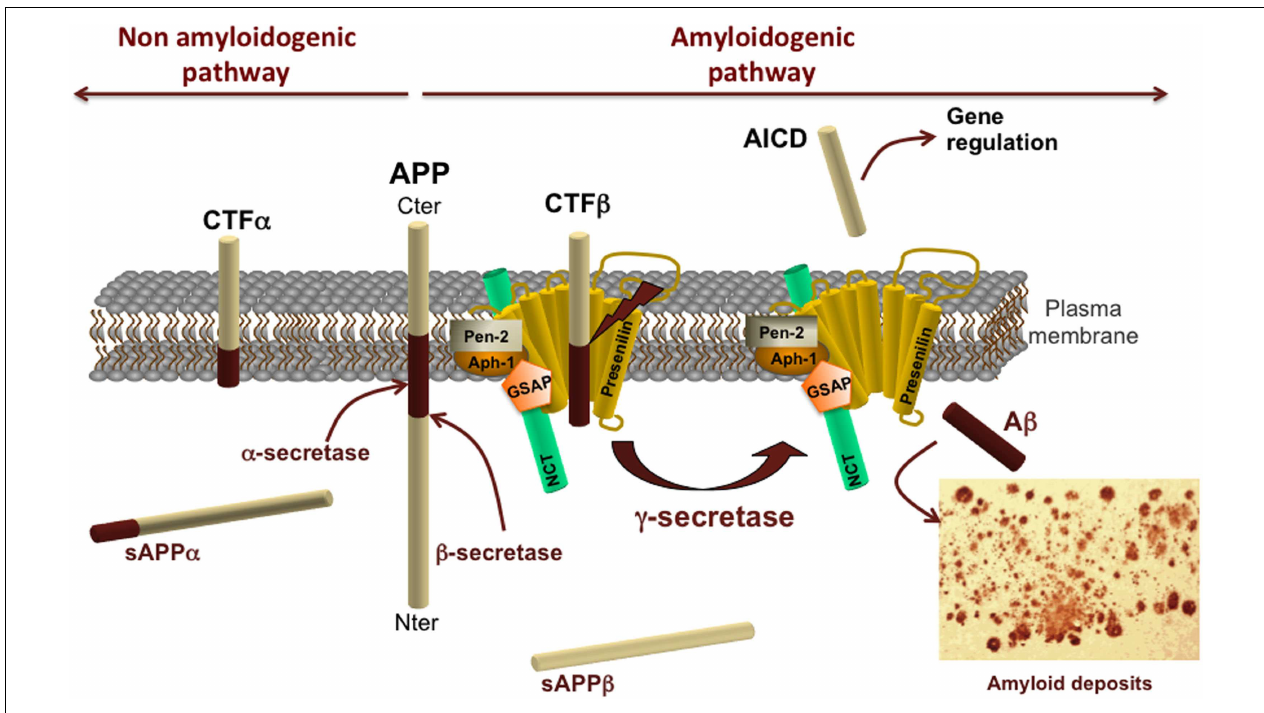
respectively a soluble fragment sAPP α or sAPP β in the extracellular space and generate carboxy-terminal fragments CTF α or CTF β .These CTFs can subsequently be processed by γ -secretase complex to generate AICD and A β .The γ -secretase complex is composed of presenilin, nicastrin (NCT), γ -secretase activating protein (GSAP), pen-2, and